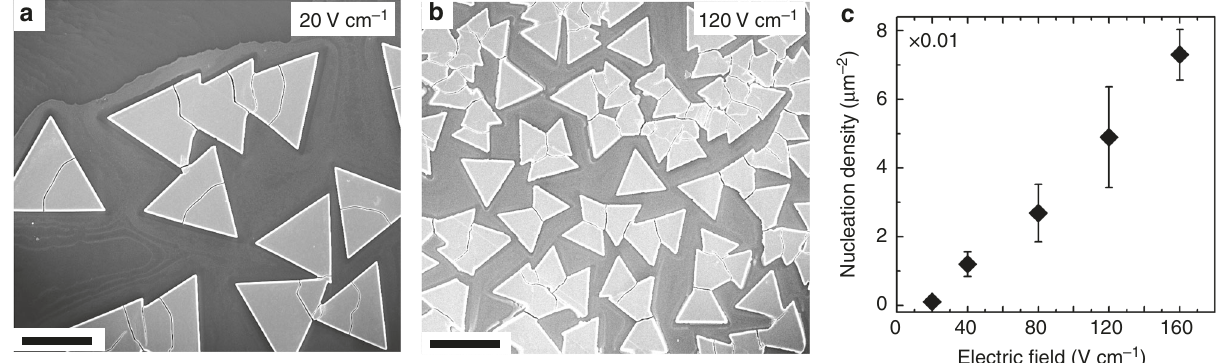
Fig. 2 Superlattices exhibit higher nucleation densities under stronger electric fi elds. a SEM image of superlattices formed under 20 V cm − 1 electric fi eld. b SEM image of superlattices formed under 120 V cm − 1 electric fi eld. Both scale bars are 20 µ m. c Nucleation density of superlattices plotted against the applied electric fi eld strength. Error bars represent root mean square variations in the number of superlattice islands averaged over >5 SEM